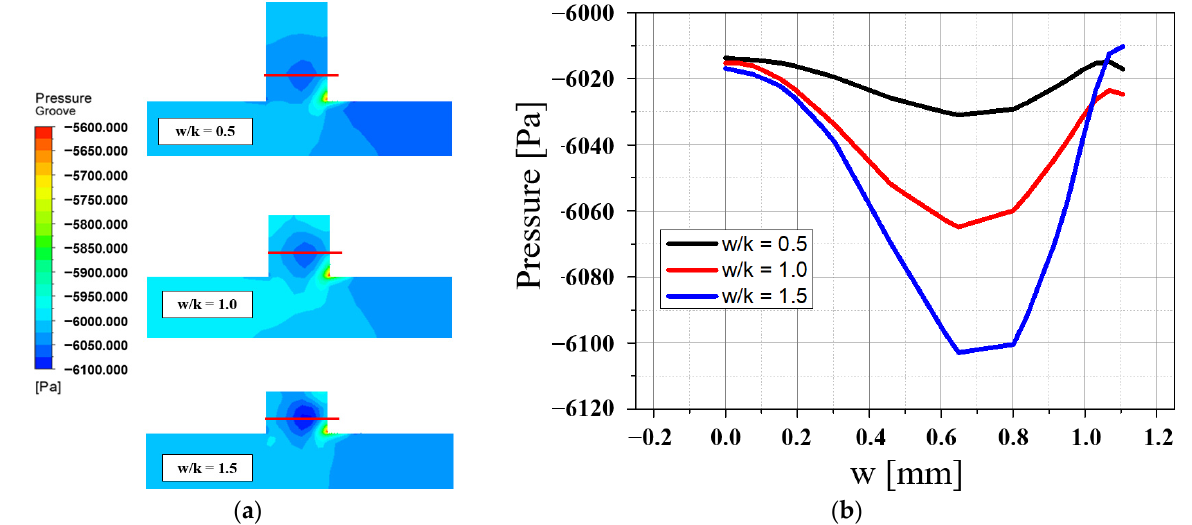
Figure 9. Pressure distribution for different w / k ; ( a ) Pressure contour near the groove, ( b ) Pressure distribution at the groove center.